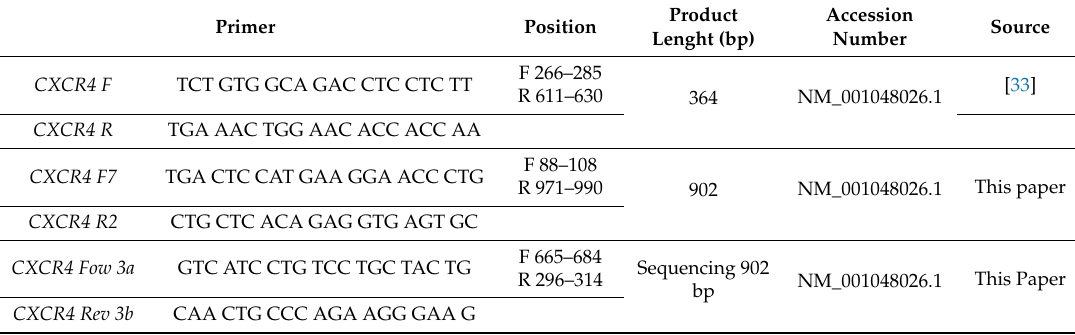
Table 3. Primers used for CXCR4 amplification and